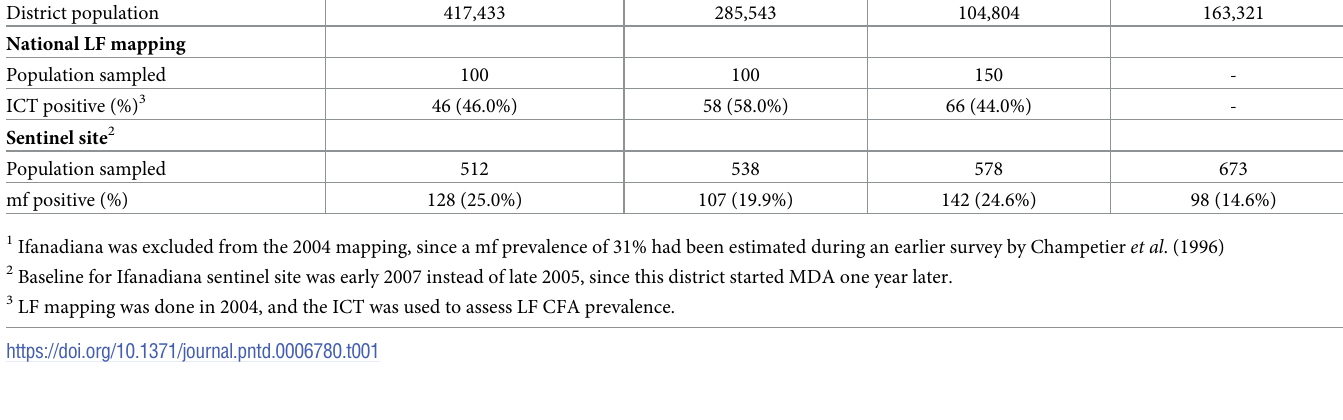
Table 1. Lymphatic filariasis baseline characteristics for each health district before initiation of MDA. Manakara Atsimo Mananjary Vohipeno Ifanadiana 1 District population 417,433 285,543 104,804